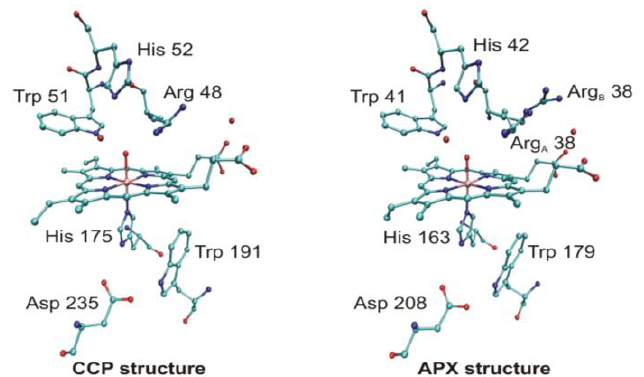
Figure 9. Schematic active-site models of cytochrome c peroxidase (CCP) ( left ) and ascorbate peroxidase (APX) ( right ). Top: distal position, bottom: proximal position, a separated red dot represents a water molecule (figure drawn on the basis of the crystal structures 1ZBZ and